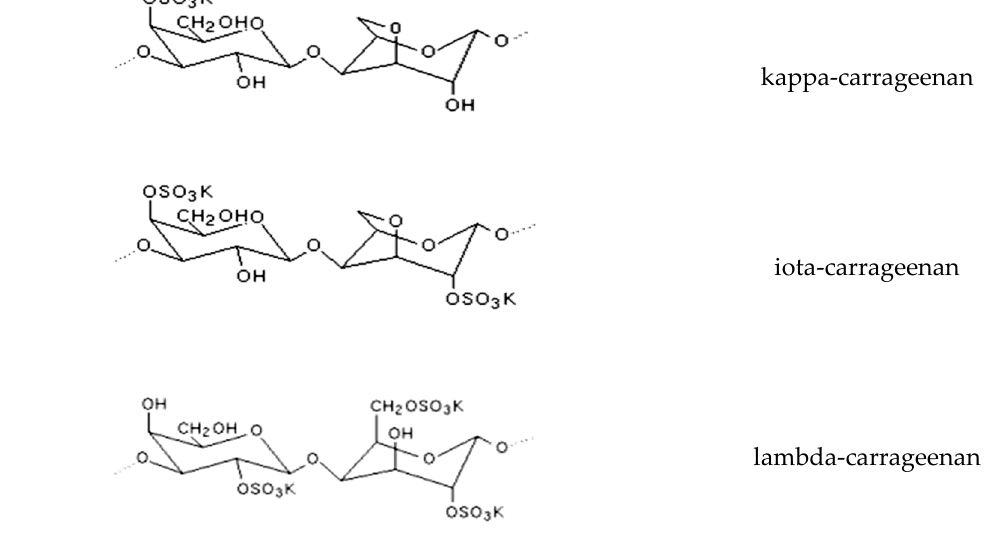
Figure 1. Di ff erent carrageenan types from red seaweeds. Figure 1. Different carrageenan types from red seaweeds.